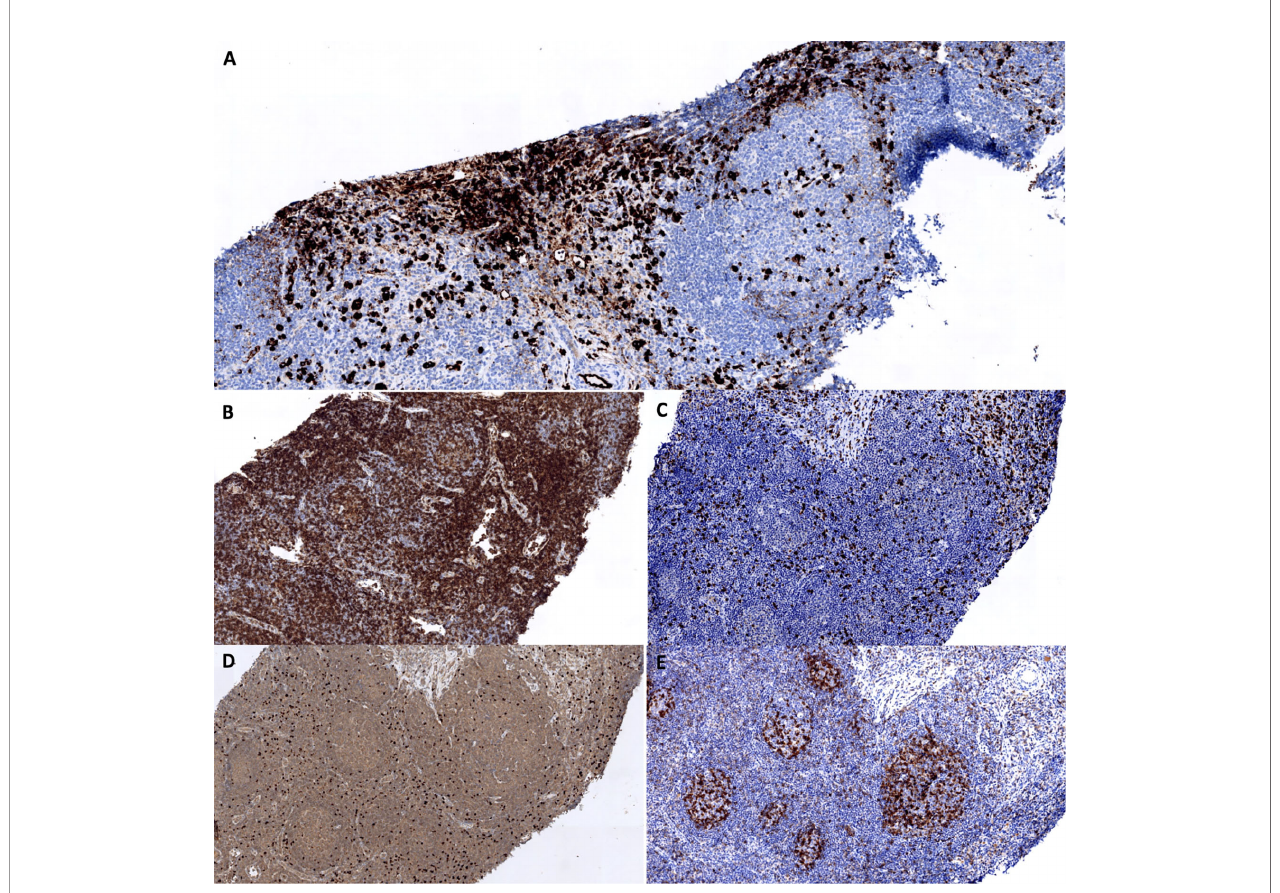
FIGURE 3 | Assessment of TFH and Treg in fi ltrates in the lymph node biopsy. (A) IgG4 staining. The interfollicular area contains numbers of IgG4 + cells. (B – E) CD4 (B) , CD8 (C) , FOXP3 (D) and PD1 (E) staining. Expansion of CD4 + PD1 + cells within follicles. Numerous CD4 + FOXP3 + cells are present in interfollicular